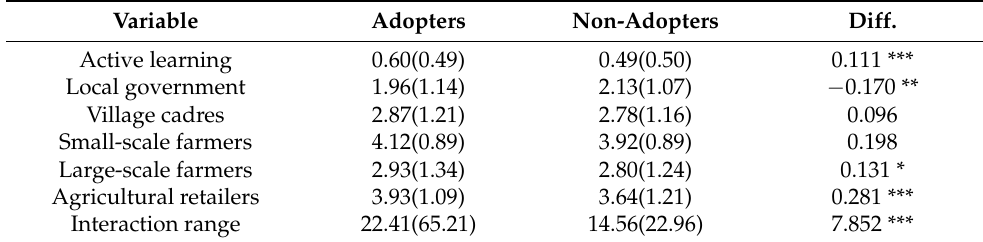
Table 4. Mean difference of active learning and social interactions between adopters and